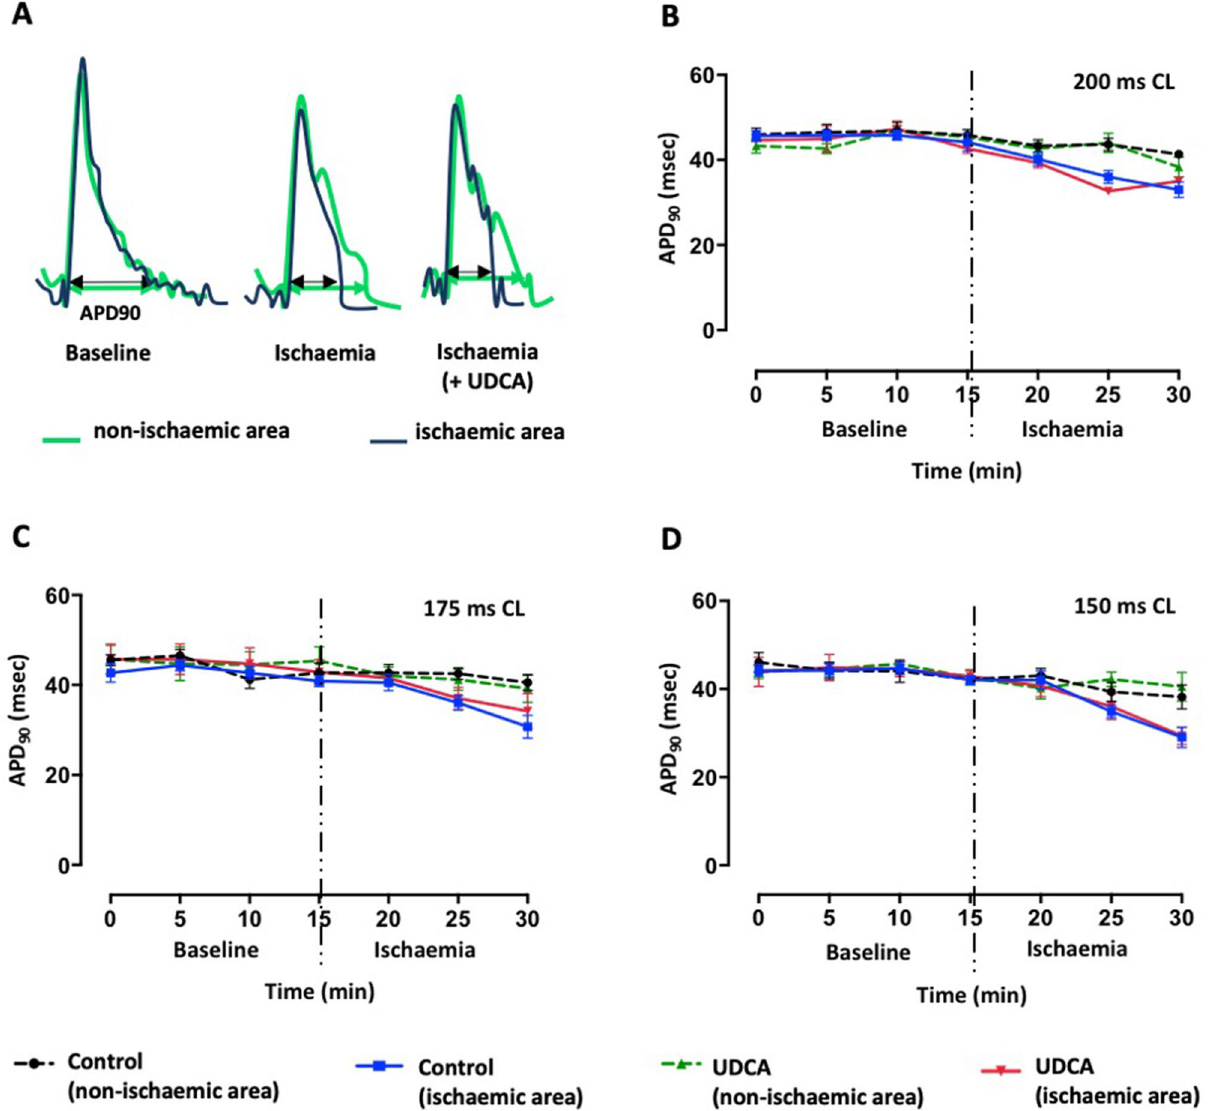
Figure 4. Summary of data on whole heart optical mapping. ( A ) Acute myocardial infarction causes action potential duration (APD)90 shortening. ( B – D ) Corresponding APD90 data from non-infarcted versus infarcted areas, at different pacing cycle lengths, showing no effect of prolonged UDCA administration against ischaemia- induced APD shortening. Data from control (n = 6) and 150 mg/kg/daily + 1 μM UDCA (n = 5) absence of UDCA, and cases (2b) and (3b) corresponded to ischaemia in the presence of UDCA that restores the phosphorylation of Cx43 (Fig. 5), and hence gap junctional coupling. Figure 6B summaries the simulated values of CV for all cases considered. In the control case (1), CV has a value of 0.8 m/s that agrees with experimental data (Fig. 3). When ischaemia was introduced, CV sharply and progressively decreased to 0.45 m/s in case 2A and then 0.35 m/s in case 3A. This was due to the dual effect of 50% coupling reduction and decrease of the cellular excitability caused by the decreased inward currents and increased resting membrane potential. The additional UDCA effect—preservation of 100% coupling in ischaemia cases 2B and 3B—resulted in attenuation of ischaemia-induced CV slowing to 0.63 and 0.5 m/s, respectively, with a consequent increase in cardiac wavelength. These values were still lower than those in control, since the excitability remained partially suppressed by ischaemia. Discussion